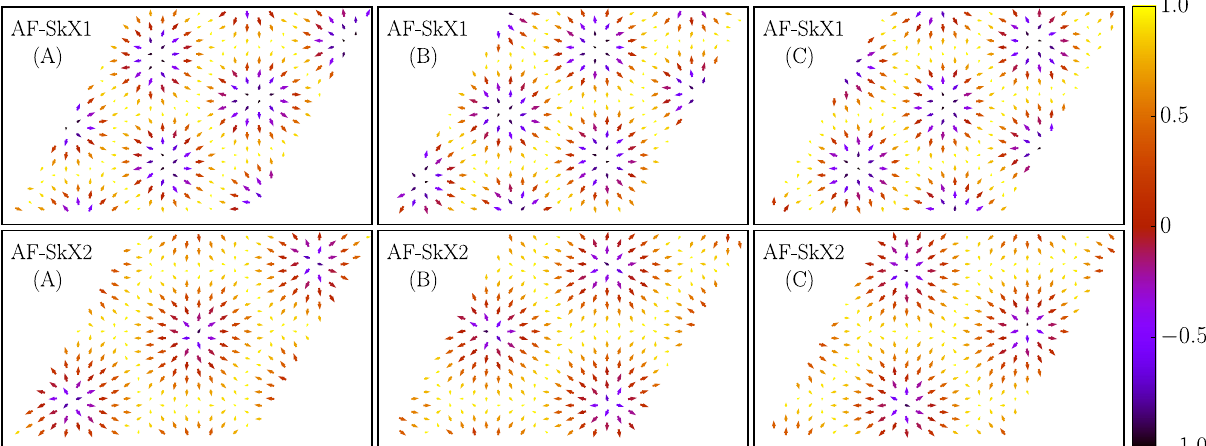
Figure 6. Sublattice resolved spin configuration plots for AF-SkX1 (upper panels) and AF-SkX2 (lower panels) states. All three-sublattices, denoted as ( A ), ( B ) and ( C ) on the vertices of a triangular plaquette, display perfect Néel skyrmion textures.